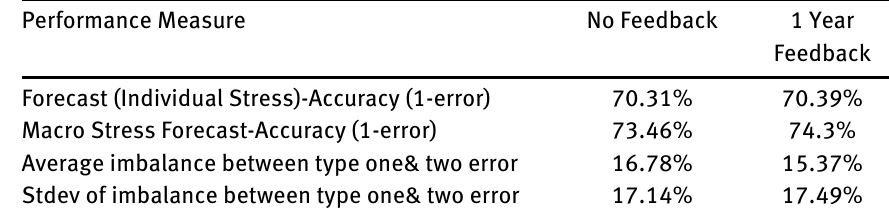
Table 2: Summary of model results with no feedback and one year feedback on in-sample data. The measures are shown in % of the underlying dataset.